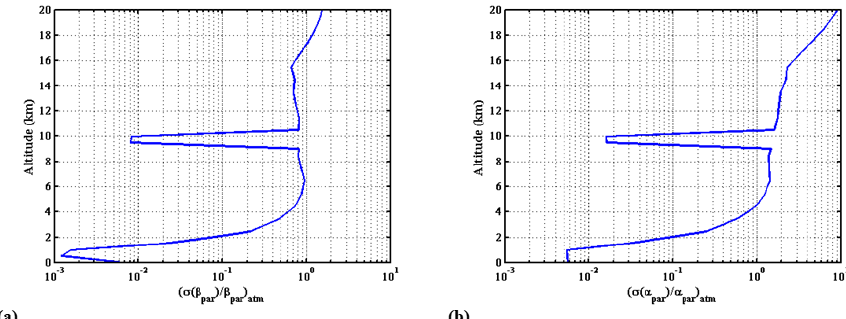
Figure 10. Relative standard deviation on β par (a) and on α par (b) for the MD plus CIR backscatter coefficient distribution caused by uncertainties of 2K in the atmospheric analysis as a function of altitude.